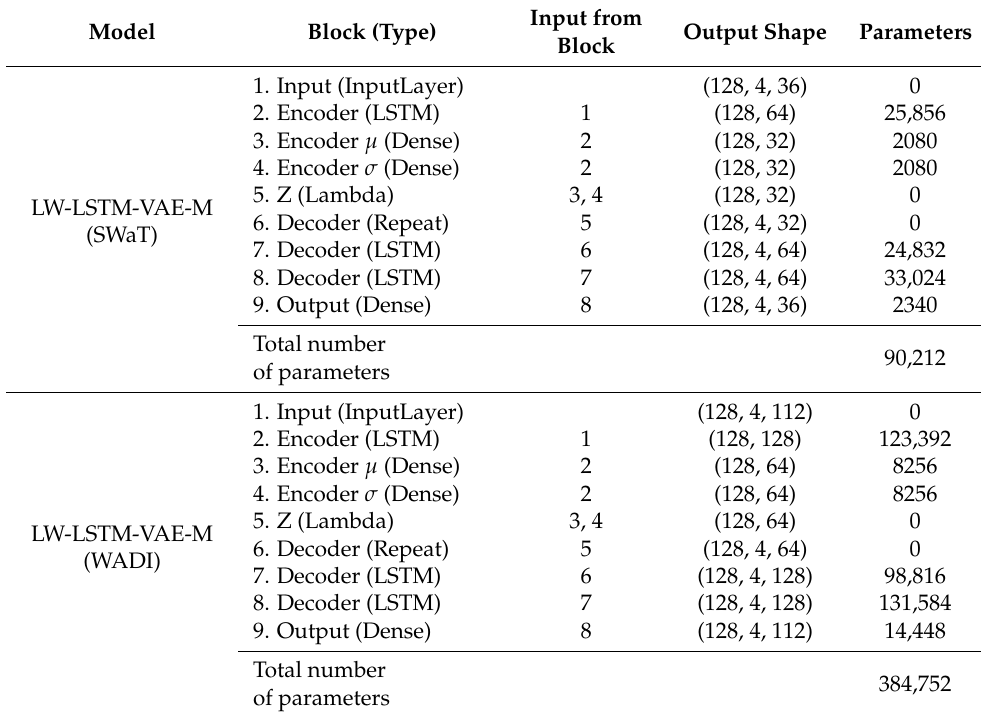
Table 6. The neural network architecture of our LW-LSTM-VAE-M models. The particular architecture blocks, the type of the blocks, the output shapes, and the number of required parameters are listed for the respective